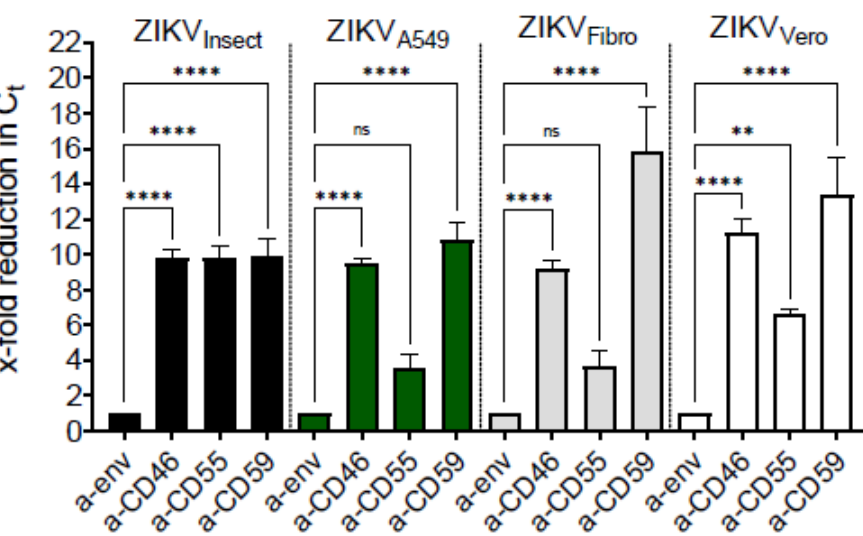
Figure 4. Capture ELISA indicates CD55 incorporation in ZIKV envelope. Graphs depict fold changes of RNA genome copies of captured ZIKV, analyzed by RT-PCR. Intact virions ZIKV A549 , ZIKV Insect , ZIKV Fibro , or ZIKV Vero were incubated overnight on pre-coated ELISA plates, bearing antibodies against human CD46, CD55, and CD59. ZIKV envelope served as a positive control. Isotype control was used as a negative control. After extensive washing steps, in order to remove unbound virions, ZIKV particles were lysed and RNA was extracted. The captured copy number of ZIKV genomes was characterized by determining the threshold-cycles by qPCR. Experiments were done two times in duplicates, and the error bars show standard deviations. Data were analyzed by ANOVA followed by Sidak’s multiple comparisons. A 95% significance level ( p < 0.05) was considered statistically significant (** < 0.01, **** < 0.001).